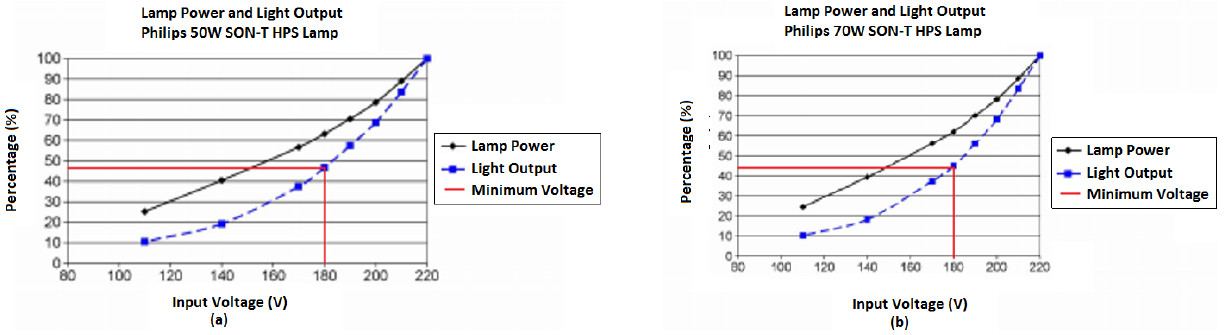
Figure 4. Lamp power, light output and minimum voltage for HPS lamps (50 and 70 W).